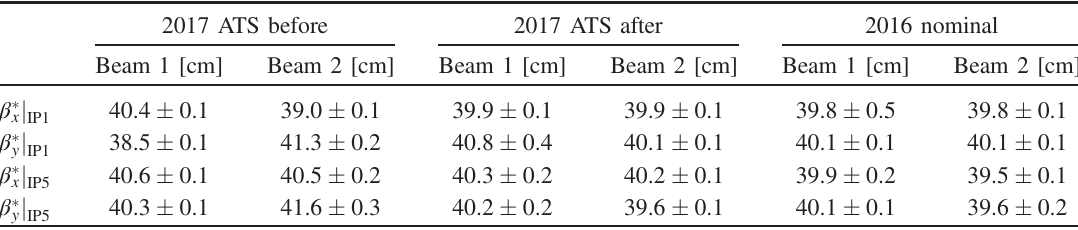
TABLE IX. β (cid:1) obtained for the operational configuration of the IR crossing scheme for β (cid:1) ¼ 0 . 4 m ATS optics in 2017 (before and after linear reoptimization), contrasted to the optics quality obtained for the nominal LHC optics at flat orbit in 2016.